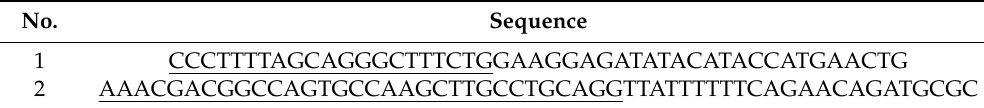
Table 3. Oligonucleotides used in this